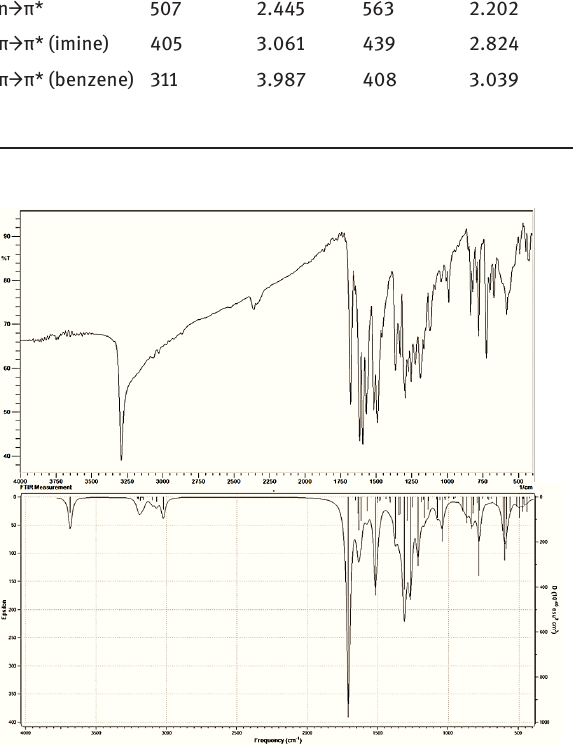
Figure 5: Experimental (above) and theoretical (below) FT-IR spectra of PINQ molecule.